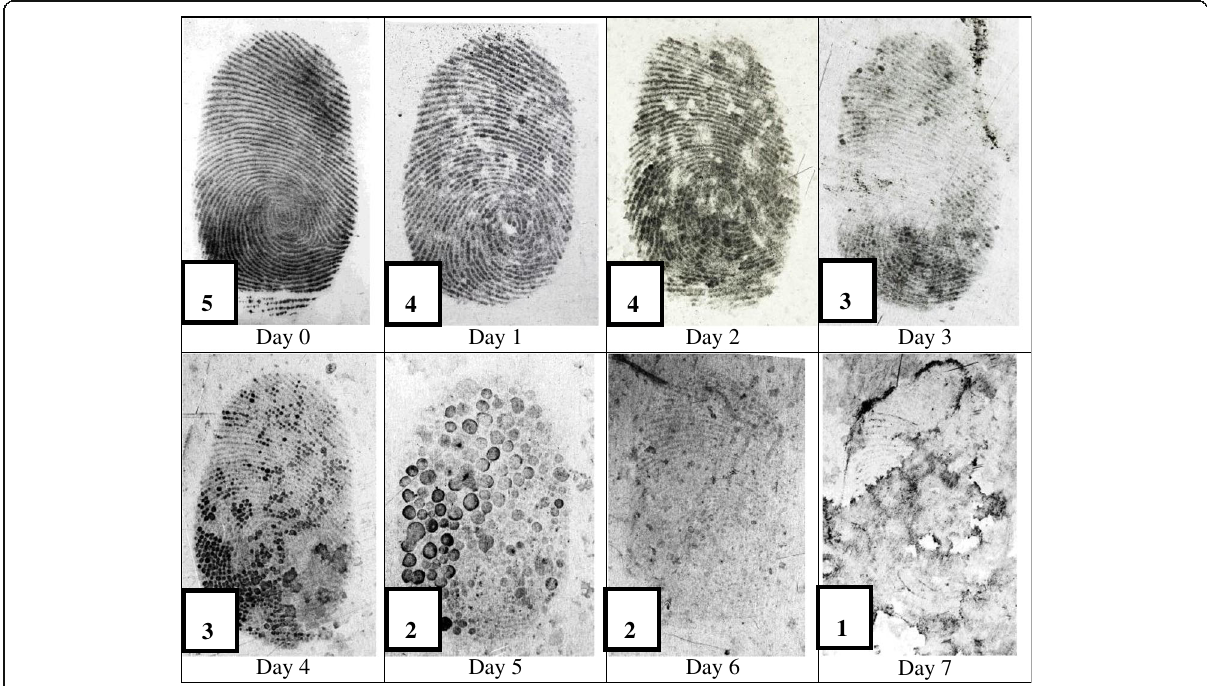
Fig. 5 Developed fingermarks using black powder dusting